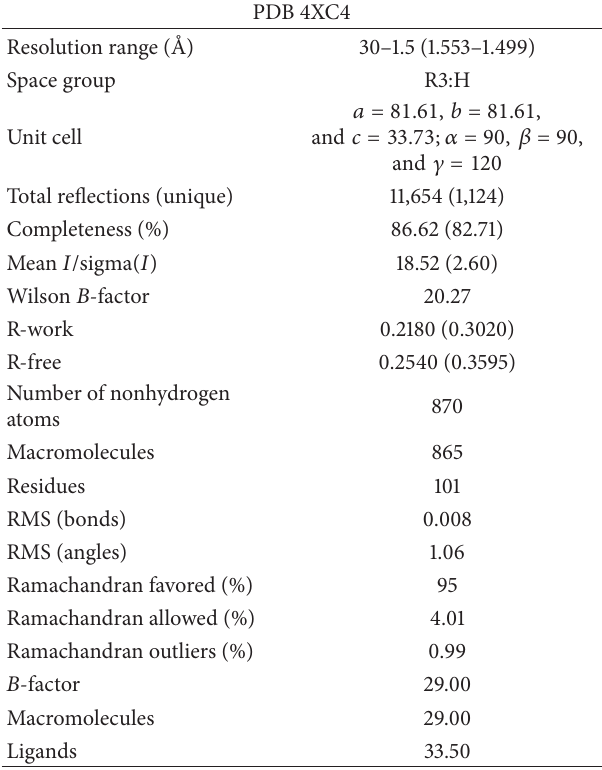
Table 1: X-ray diffraction data for insulin crystalized in the presence of